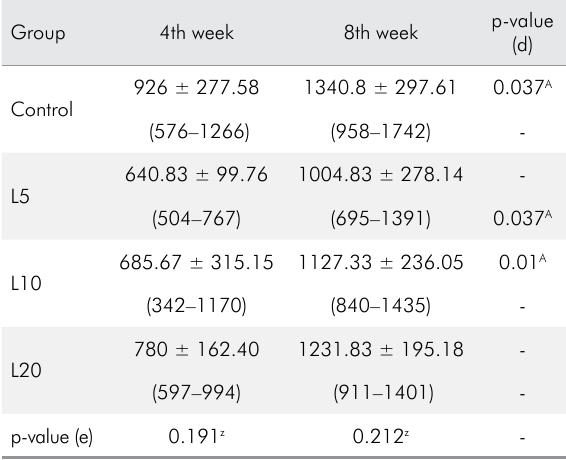
Table 1. Analysis of osteocyte number among groups and dependent on time. Data presented as mean ± standard deviation